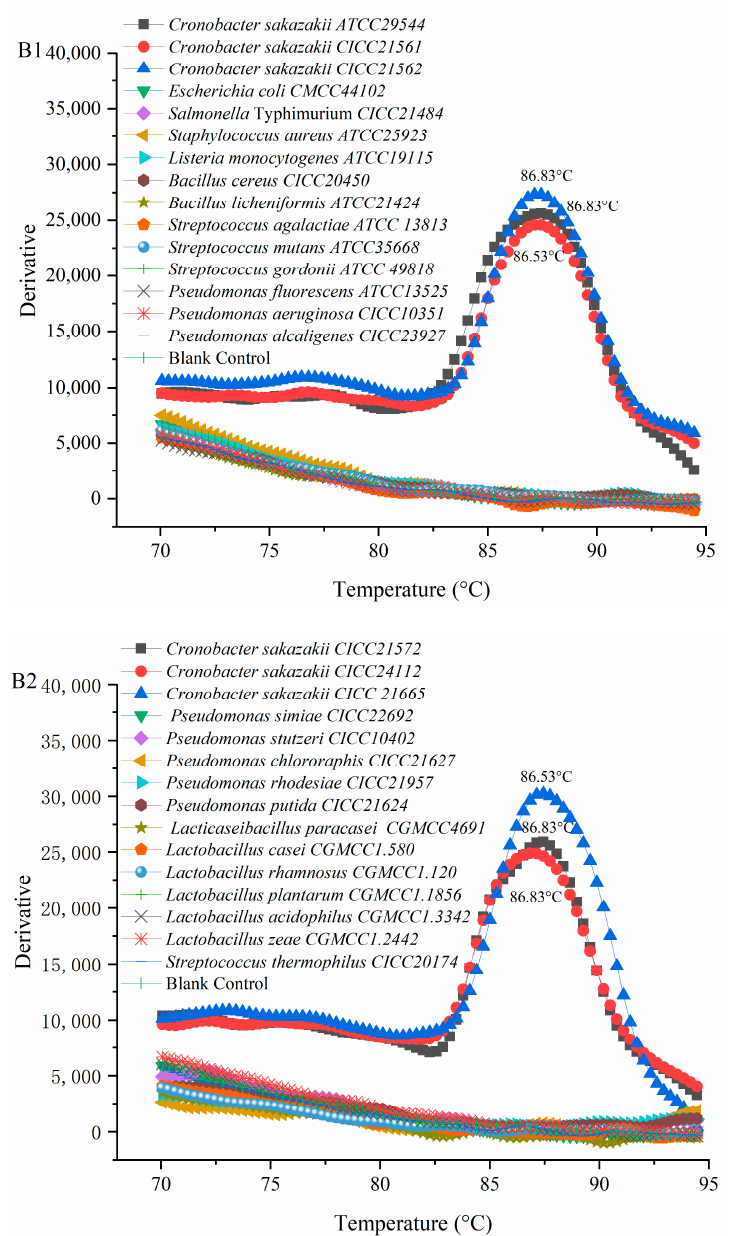
Figure 2. Specificity verification of PMA-QLAMP method. ( A1 , A2 ) Specific amplification curve of PMA-QLAMP. That was, the C. sakazakii amplification curves of ATCC29544, CICC21561, and CICC21562 in ( A1 ), CICC21572, CICC24112, and CICC2166 in ( A2 ) all showed S-shaped curves. The amplification curve of 24 non- C. sakazakii strains and the blank control showed a horizontal straight line, and the fluorescence intensity (delta Rn) remained at about 0. ( B1 , B2 ) Melting curve of the amplified products PMA-QLAMP. In the temperature range of 70–95 ◦ C, i.e., ATCC29544, CICC21561, and CICC21562 in ( B1 ), CICC21572, CICC24112, and CICC2166 in ( B2 ), the melting curve of the amplified products of C. sakazakii was unimodal, and the X-axis temperature corresponding to the highest peak of the curve was the melting temperature. In ( B1 ), the melting temperatures of C. sakazakii ATCC29544, CICC21561, and CICC21562 were about 86.83, 86.53, and 86.83 ◦ C, respec- tively. In ( B2 ), the melting temperatures of C. sakazakii CICC21572, CICC24112, and CICC2166 were about 86.83, 86.83, and 86.53 ◦ C, respectively. The melting curve of 24 non- C. sakazakii strains and the blank control were a straight line, respectively. They had no unimodal curve and corresponding melting